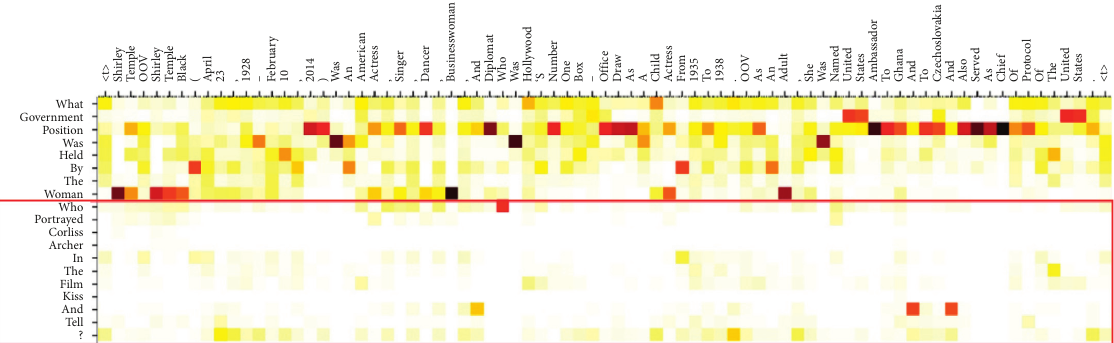
Figure 5: Attention heat map of the dual/ans model.